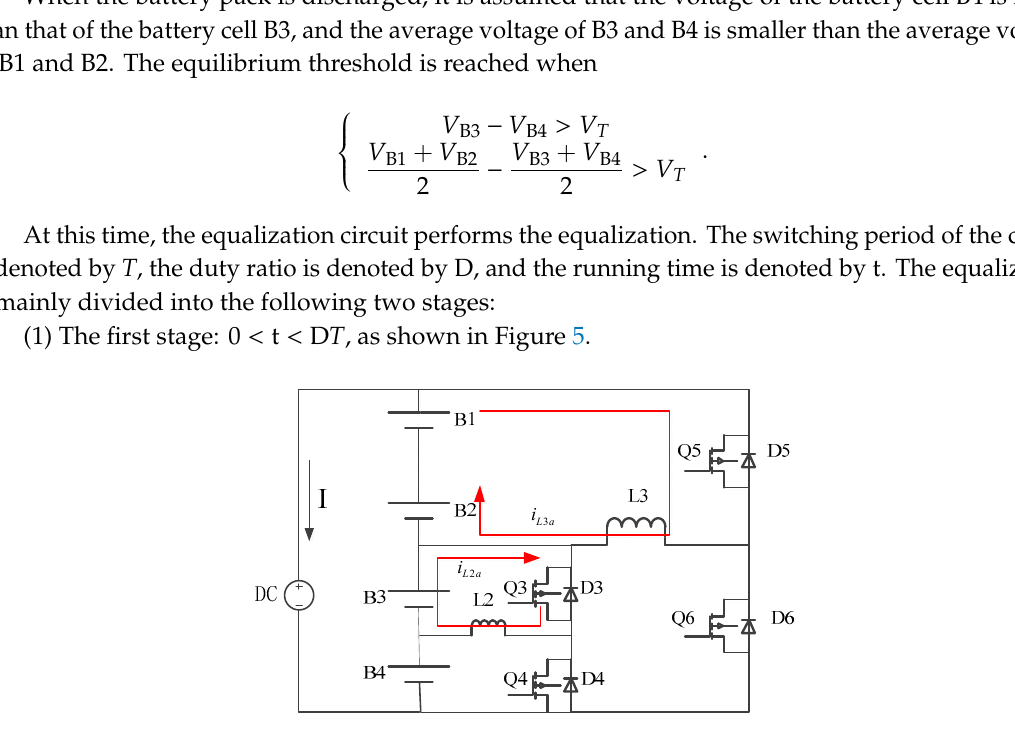
Figure 5. Schematic of the first stage of discharge